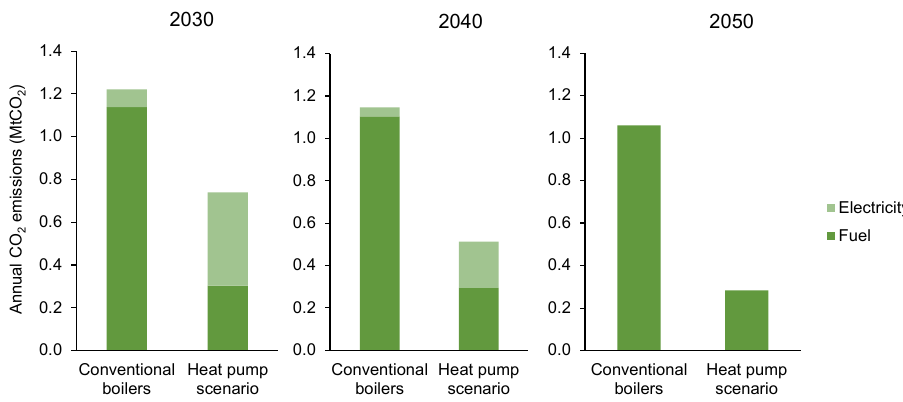
Figure 12. Annual CO 2 emissions from the textile wet-processing industry in Taiwan. The transition from conventional boilers to industrial heat pumps in the textile indus- try will have a cost implication. We estimated the energy costs per unit of production (USD per tonne of finished fabric) for the textile wet-processing industry in each economy (Figures 13–15). As can be seen, in all three economies, switching from combustion boilers to IHPs will result in lower energy costs per tonne of finished fabric produced even in the base year, even though the electricity prices in all three economies are substantially higher than fossil fuel prices per unit of energy (kWh). This lower energy cost per unit of production by IHPs is primarily because heat pumps have high efficiency (as explained earlier) and will result in substantial overall energy savings (see Figures 7–9).